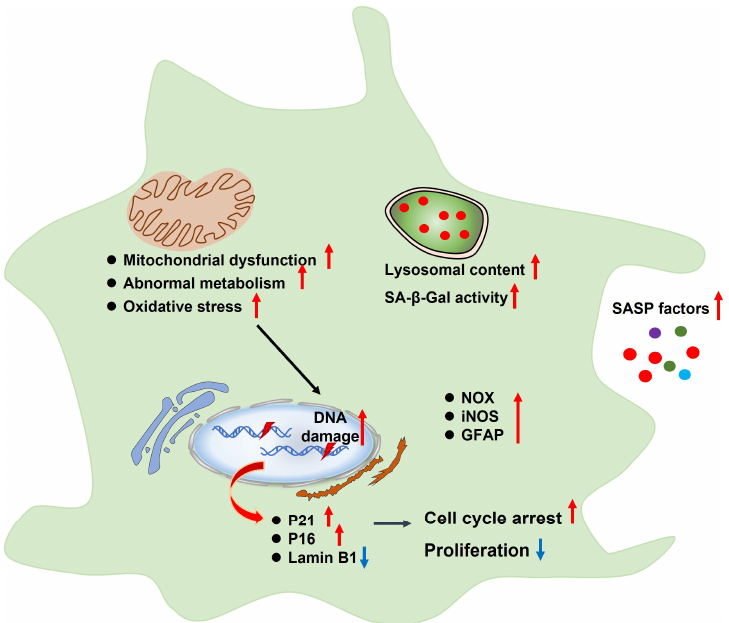
Figure 3. Characteristics of senescent astrocytes, such as cell cycle arrest and decreased prolif- eration, which are accompanied by mitochondrial dysfunction, abnormal metabolism, increased lysosomal content, SA- β -Gal activity, oxidative stress, DNA damage, senescence-associated gene ex- pression, and SASP release. SASP, senescence-associated secretory phenotype; SA- β -Gal, senescence- associated β -galactosidase; NOX, NADPH oxidase; iNOS, inducible NO synthase; GFAP, glial fibrillary acidic